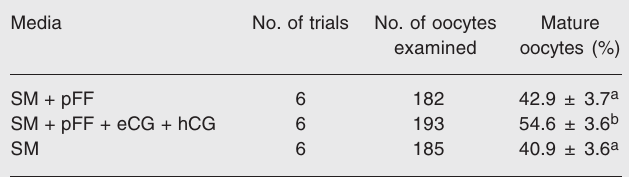
Table 1. Pig oocyte maturation in vitro in a culture system with pyruvate.